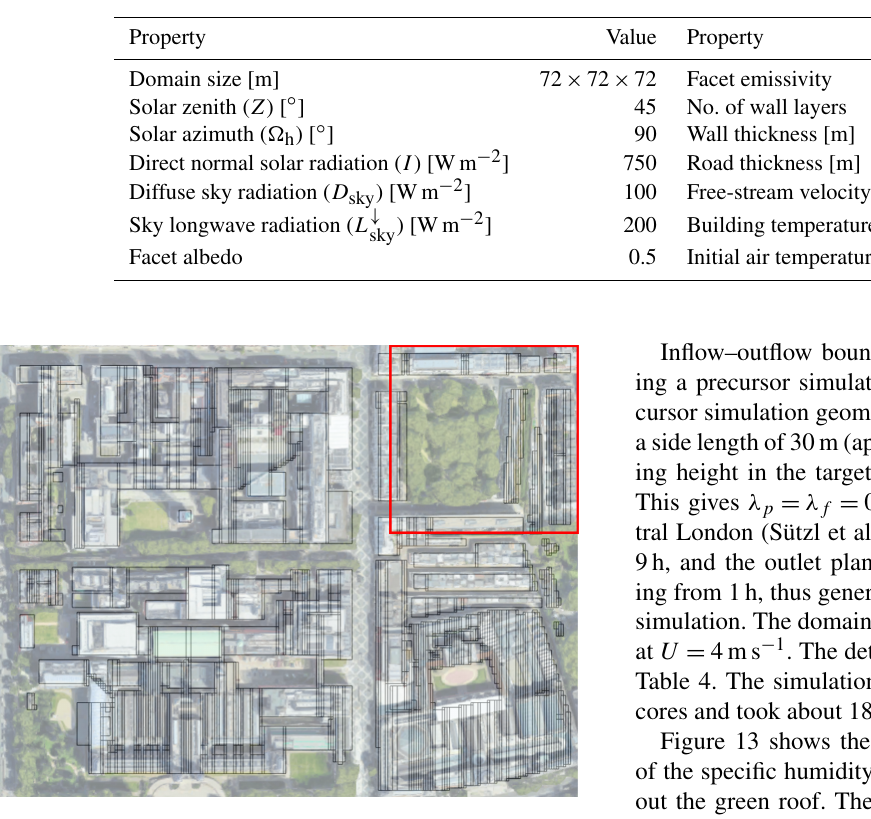
Figure 12. Morphology of the South Kensington campus and sur- roundings divided into building blocks and overlaid over an aerial image. Imagery: © 2022 Google, © 2022 Bluesky, CNES/Airbus, Getmapping plc, Infoterra Ltd & Bluesky, Maxar Technologies, The GeoInformation Group. Map data: © 2022